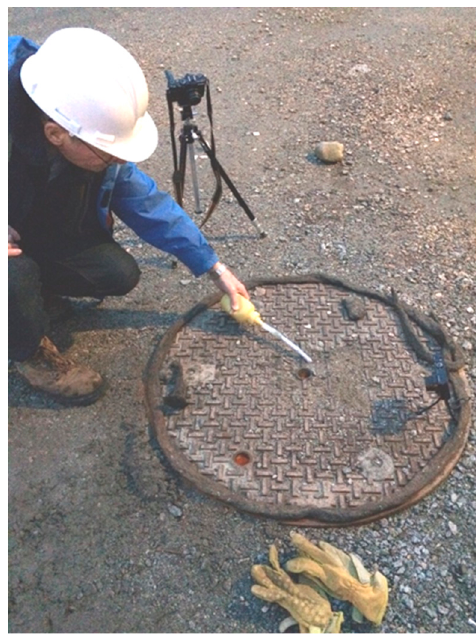
Figure 1. ‘Smoke’ generation. ‘Smoke’ tubes produce aerosols through chemical reaction that resembles smoke. The ‘smoke’ visualizes air movement when generated in a non-aggressive manner by gently squeezing the plastic container. The camera used externally is readily visible on the tripod. A low oblique angle off axis to the side is the best location for capturing images and video.